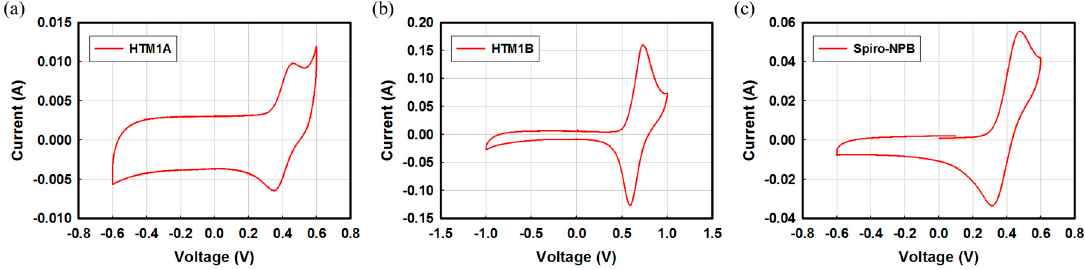
Figure 2. Cyclic voltammetry measurements of HTMs 1A ( a ), 1B ( b ) and Spiro-NPB ( c ).